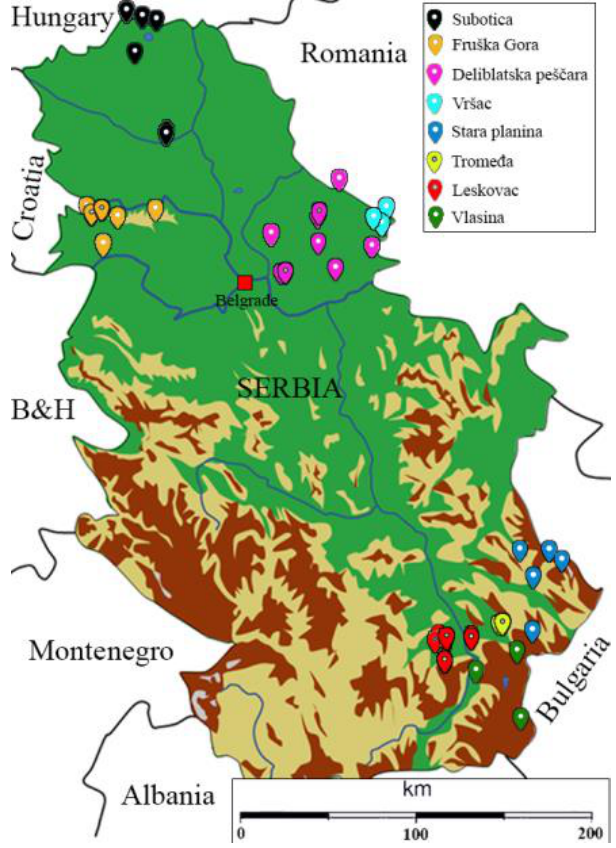
Figure 1. Sampling locations: Subotica (S), Fruška gora (FG), Deliblatska peščara (DS), Vršac (Vr), Stara Planina (SP), Tromeđa (T), Leskovac (L) and Vlasina (V). A total of 1696 sequences from neighbouring countries and Serbia originating from different time periods and deposited in NCBI GenBank [12,24,33,36,39,41,44–49] were used for comparison (Table S2).